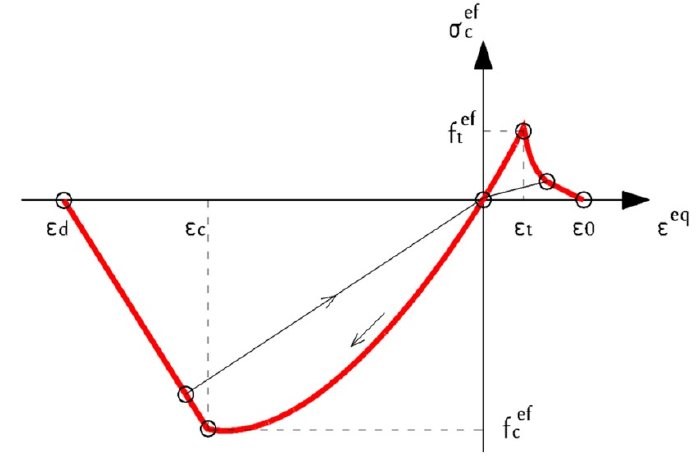
Figure 11. Uniaxial stress–strain diagram of concrete in compression and tension.